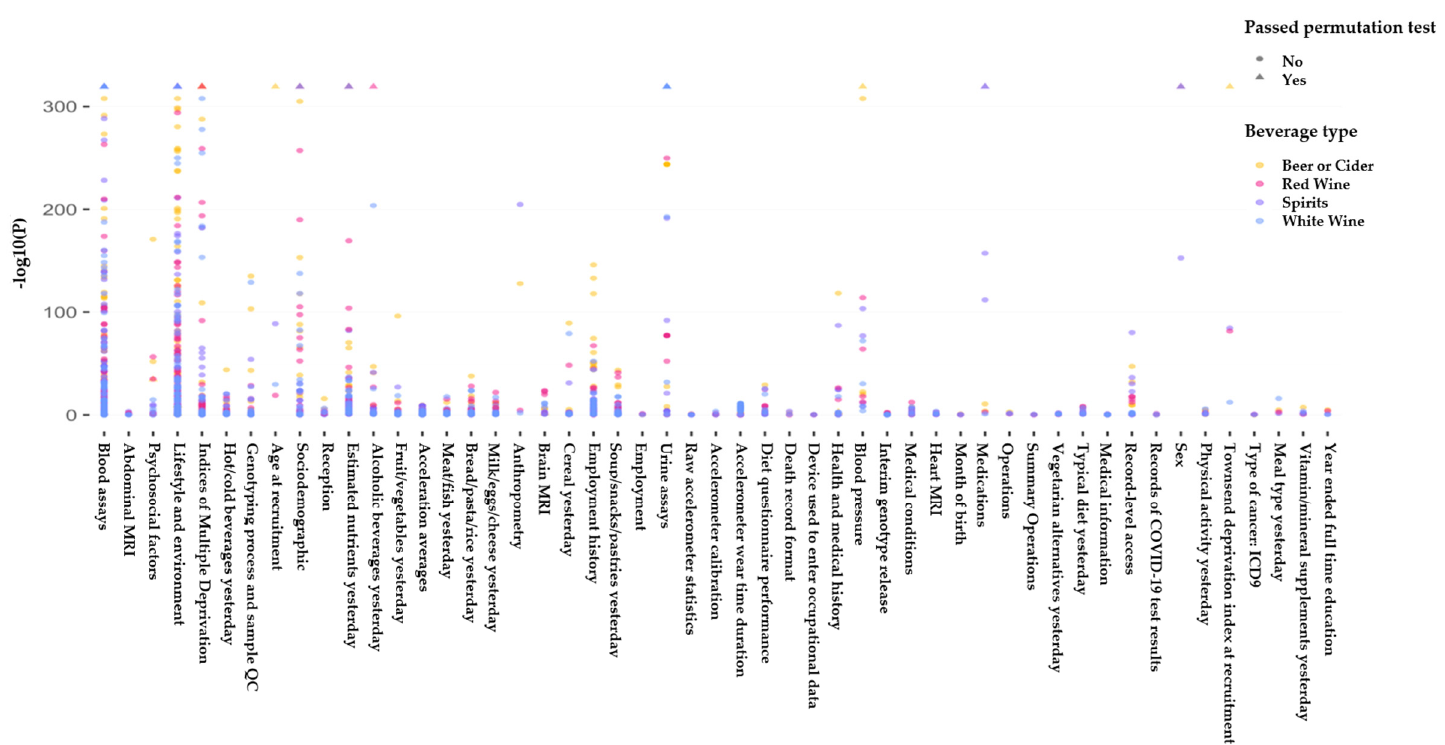
Figure 3. Overview of the agnostic association analyses. The Manhattan plot illustrates negative log10 observed p -values for general linear models created for the association of UK biobank phenotypes with consumption of various alcoholic beverages (e.g., beer, cider, spirit, red, white, and fortified wine). UK biobank phenotypes have been categorized into groups for the purpose of visualization in this figure. To account for multiple testing, significant models were selected using the permutation method, which estimates the likelihood of the observed associations to be driven by chance. We simulated chance finding by repeating each association test 10,000 times with the outcome that was randomly sampled. If more than 5% of the random associations led to p -values that were less that the observed p -value (obtained from our UK Biobank data), we concluded that the observed p -value is likely to be driven by chance and therefore we did not accept them as significant models. Models that passed the permutation test are plotted as triangles and models that did not pass the permutation test are plotted as circles. Beer/cider results are plotted in yellow, red wine results are plotted in pink, spirit results are plotted in purple, and white wine results are plotted in blue.